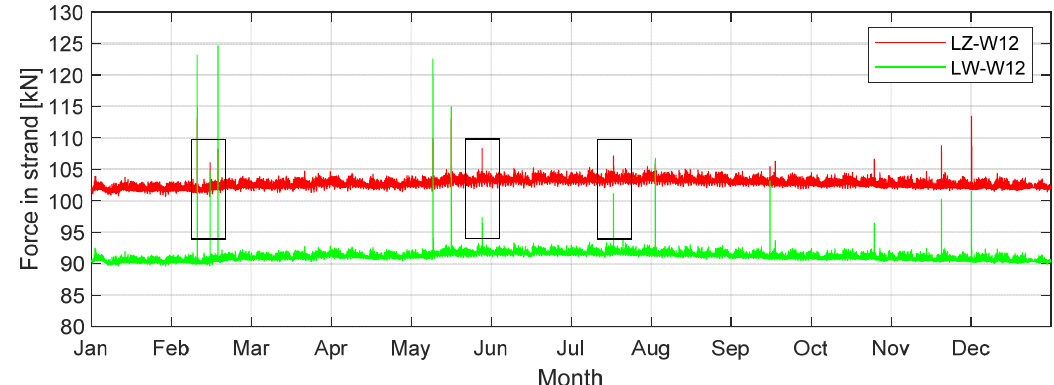
Figure 11. Force diagram in the middle-length cables LZ-W12 and LW-W12 with selected maximum force peaks in 2017.